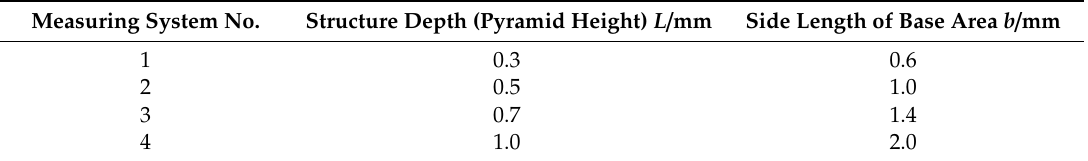
Table 1. Geometric dimensions of the pyramidal structure, R = 12.5 mm. Measuring System No.